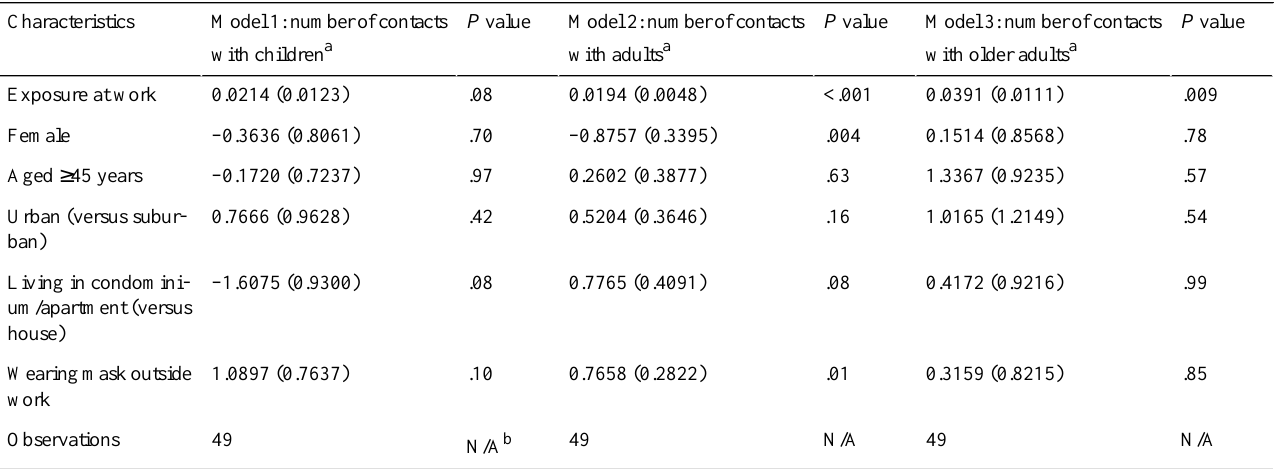
Table 3. Relationship between survey respondent characteristics and number of daily contacts in Vermont between April 20 and May 13,